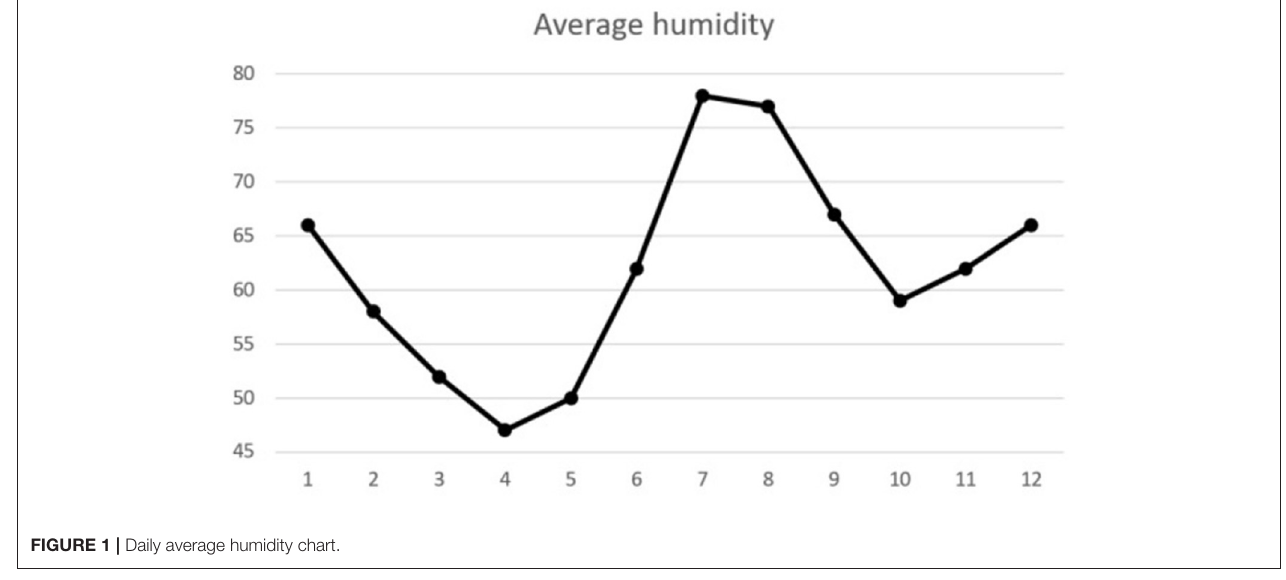
FIGURE 1 | Daily average humidity chart.